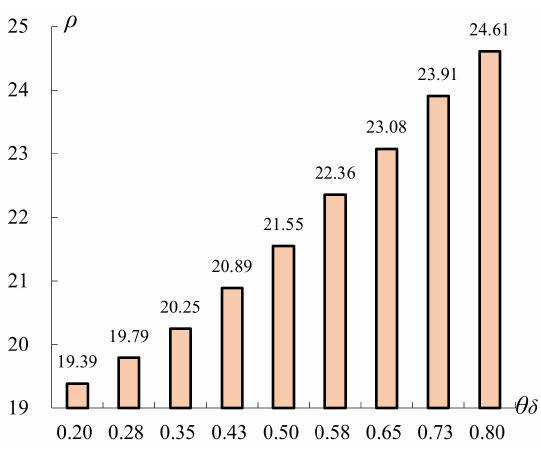
Figure 2. E ff ect of θ δ on ρ .